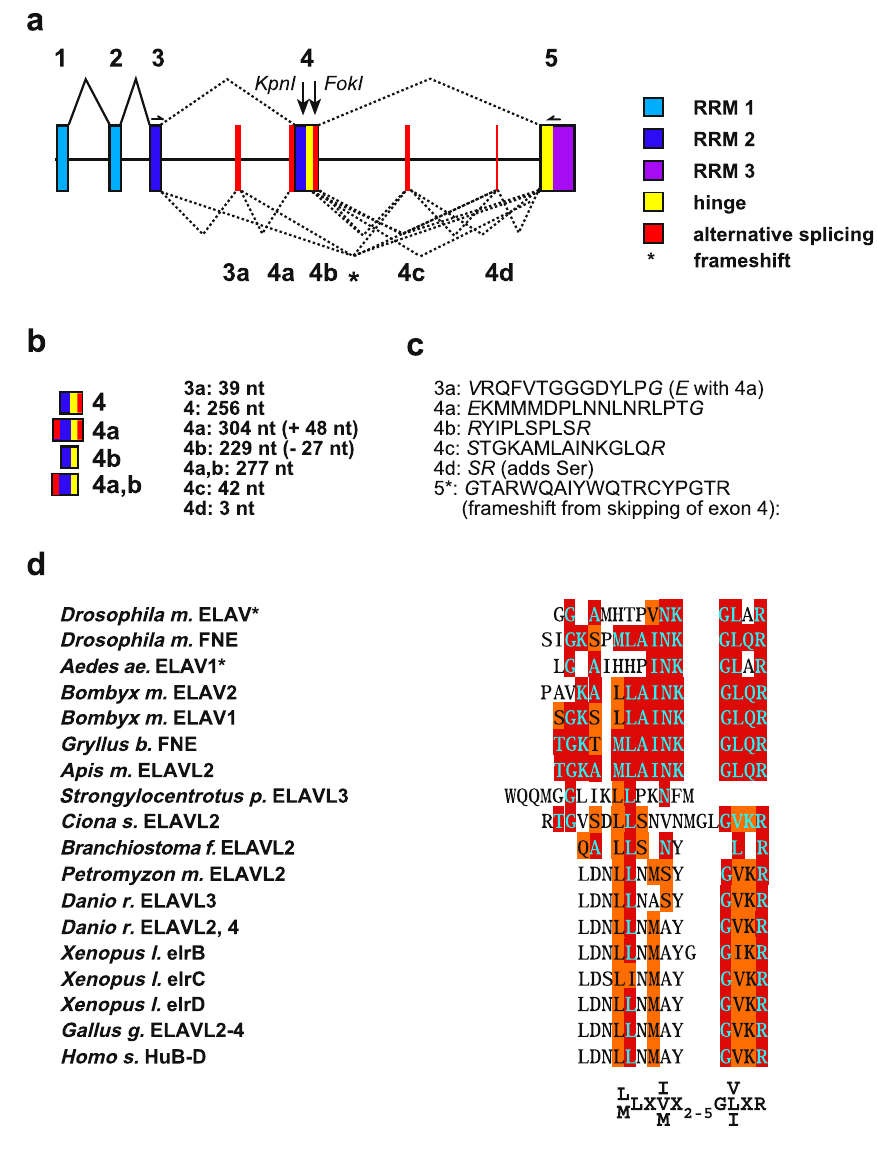
Fig. 2 Single bee elavl2 gene is alternatively spliced. a Gene model of Apis mellifera elavl2 gene depicting exons (boxes) and their splicing. Constant splicing is indicated by solid lines and alternative splicing is indicated by dashed lines. In total, 40 different alternative splice products are possible. Skipping of exon 4 variants results in a frameshift in exon 5 (indicated by an asterisk). b Depiction of exon 4 variants and length of alternative microexons. c Sequence of alternative microexons and frameshift in exon 5* from skipping of exon 4 variants. d Alignment of alternative microexon 4c from bees with a part present in Drosophila ELAV or alternatively spliced microexons in ELAV/Hu family proteins of other species with a consensus motif shown at the bottom. Retroposed genes lacking introns are indicated by an